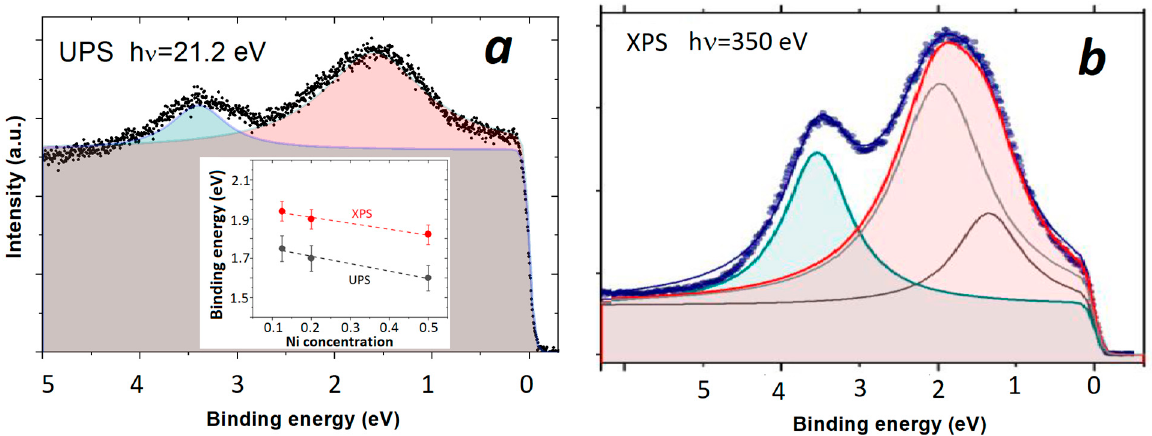
Figure 5. ( a ) UPS and ( b ) XPS of (TiZrNbCu) 0.5 Ni 0.5 alloy. The inset shows the shift of Ni-related spectral maximum with Ni concentration.